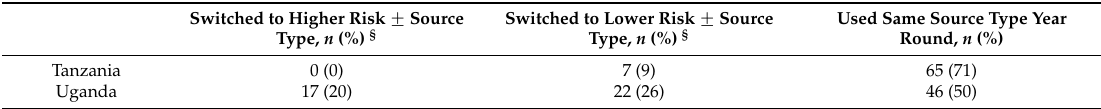
Table 1. Households using the same or a different source type from wet to dry season. Switched to Higher Risk ˘ Source Switched to Lower Risk ˘ Source Type, n (%) § Type, n (%) § Tanzania